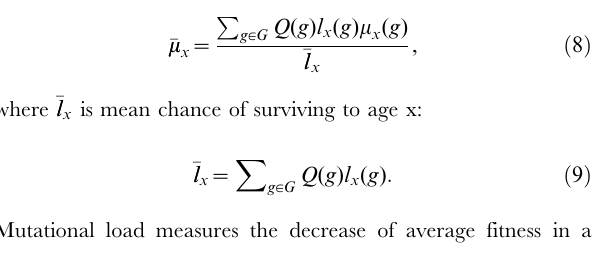
Table 2. Effect of selection on genotypes frequencies.